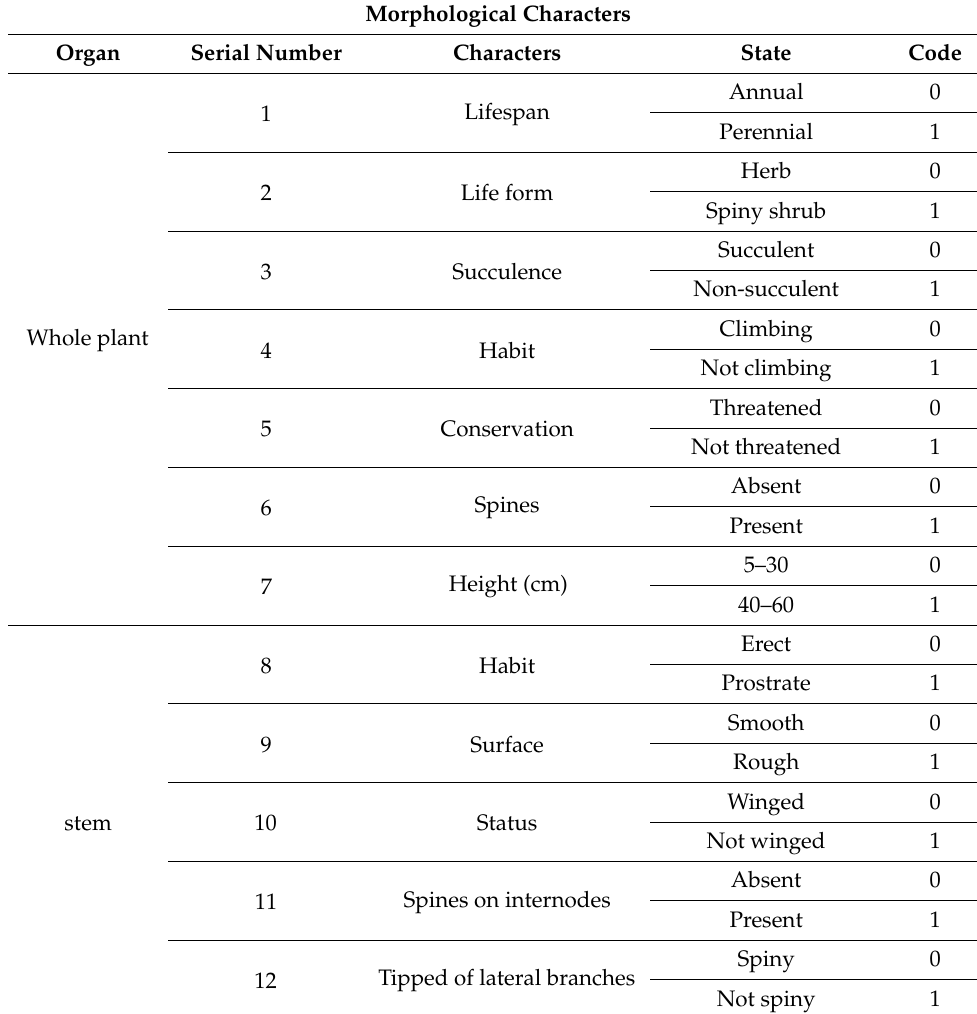
Table 2. The qualitative and quantitative investigations of the 35 Morphological characters and their codes for numerical analysis of all studied